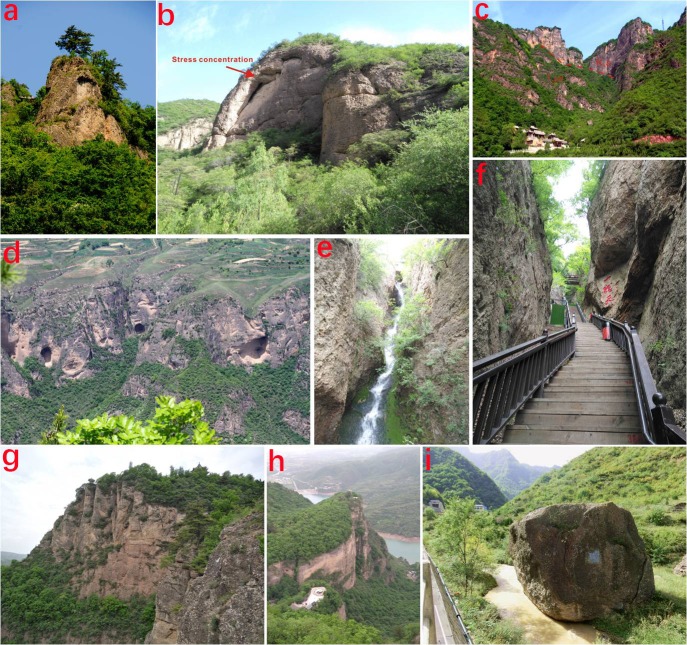
Geomorphic features of Danxia landform in the KNG.(a) Candle Peak, (b) Mt. Elephant, (c) an unconformable contact at Wendaogong, (d) caverns at Yanzhixia, (e) V-shaped valley at Yehu bridge, (f) narrow gorge (A Thread of Sky), (g) vertical joints at Five-finger Peak, (h) escarpment at Nantai, and (i) colluvial rock block in Yanzhi River (Erlang stone). Fig 4C and 4D panels are excluded from this article's CC-BY license. See the accompanying retraction notice for more information.